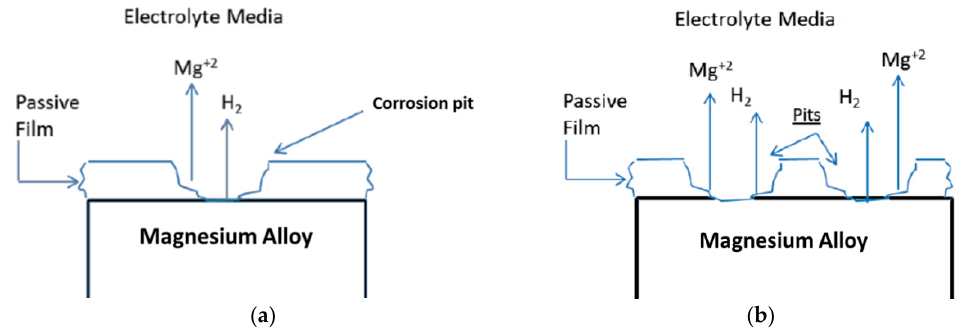
Figure 16. Model of partially protective surface film at low ( a ) and high ( b ) applied potential ( E ) or current ( I ). Modified from [85].